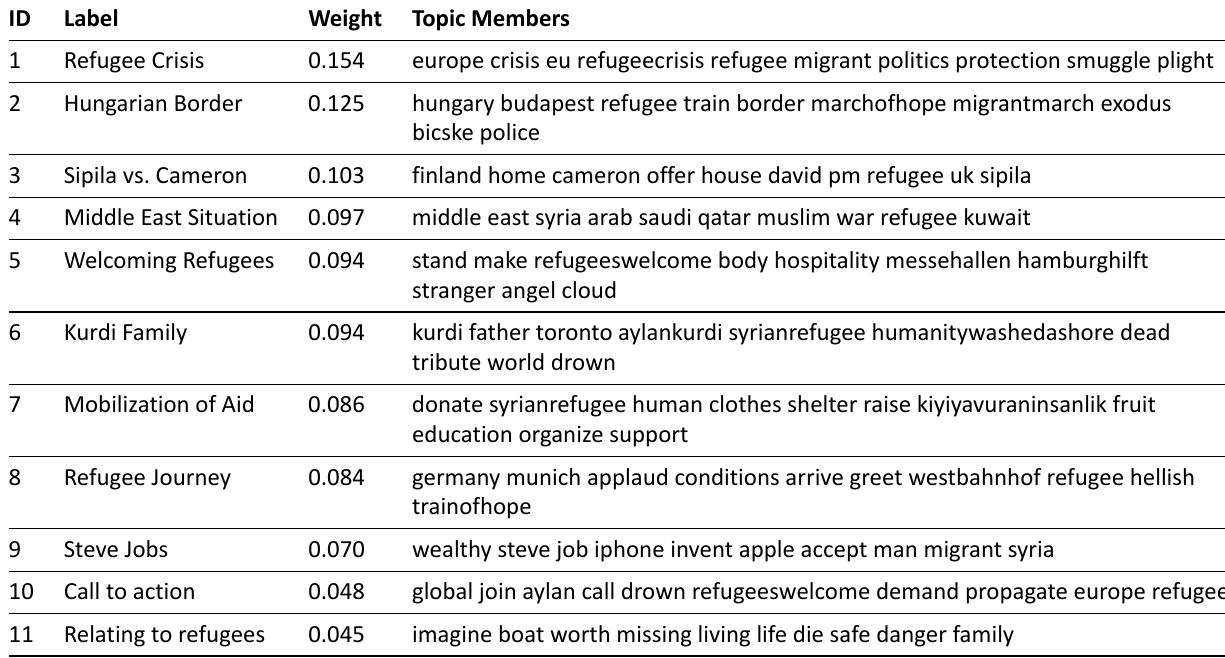
Table 2. Topic modeling for the Twitter data.